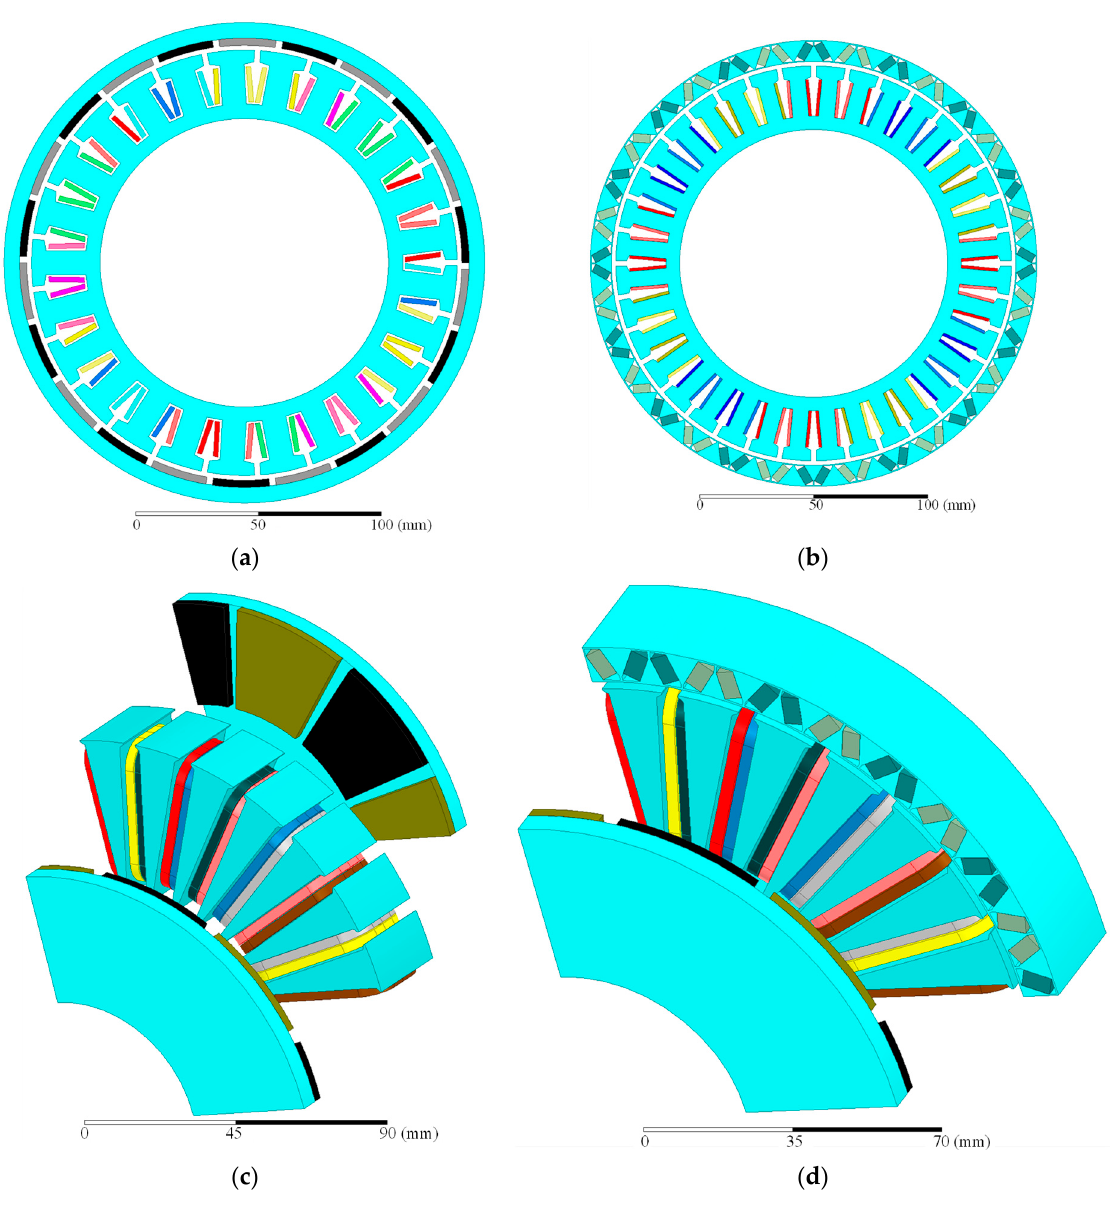
Figure 1. Four types of outer-rotor in-wheel motors: ( a ) five-phase SPM; ( b ) three-phase V-shaped IPM; ( c ) seven-phase AFM; ( d ) seven-phase HFM.